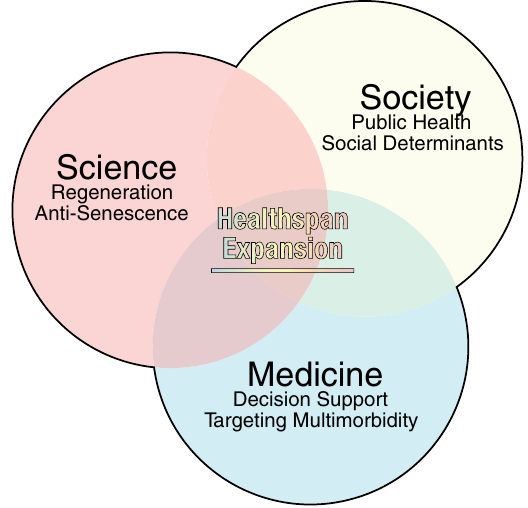
Fig. 3 Healthspan extending toolkit. Healthspan extending strate- gies are comprehensive, relying on the unison of social, clinical and scienti fi c programs. Societal initiatives include public health promotion and targeting of social determinants. Augmented decision making, harnessing multimodal datasets, has enhanced clinical management in the elderly. Breakthroughs in the anti- senescence and regenerative arsenal aim at curative